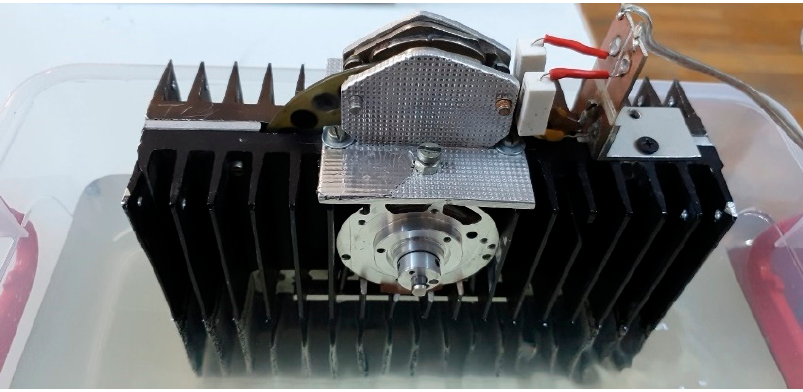
Figure 7. Experimental stand of the gadolinium motor—variant 2 [25].